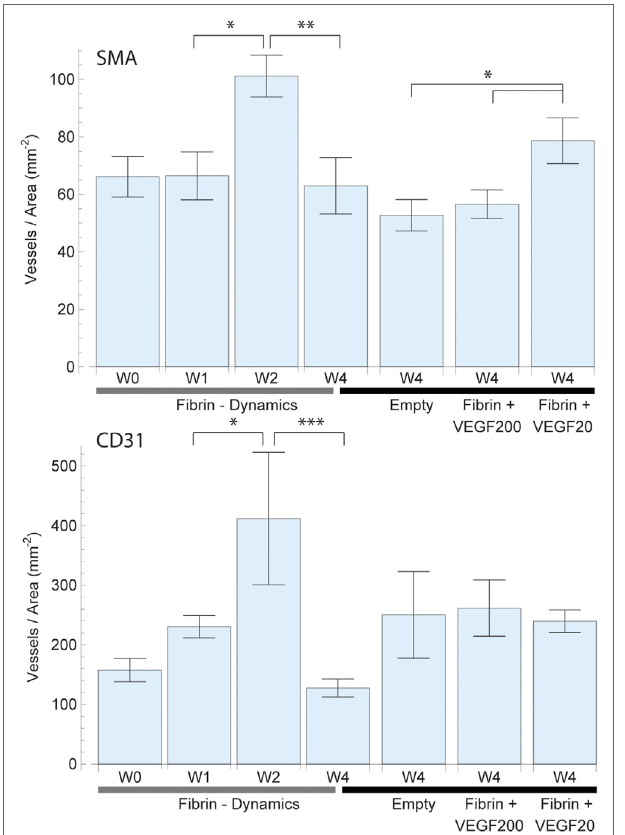
FIGURe 4 | Mean vessel density based on the vascularized area of each individual sample for smooth muscle actin (SMA) (top) and CD31 (bottom) staining. The total vascularized area was calculated by expanding and adding up each vessel cross section by a defined radius of 150 µm representing the potential diffusion of oxygen into the tissue. Overlapping areas were single counted. The left 4 bars indicate the change in vascular density in fibrin over a period of 4 weeks, which peaked at week 2. The right 4 bars indicate the effect of high dose (200 ng) and low dose (20 ng) recombinant human vascular endothelial growth factor (rhVEGF165) in a fibrin matrix in comparison to pure fibrin and no matrix. The 20 ng rhVEGF165 group yielded the best results and a statistical significant difference to the empty control group was